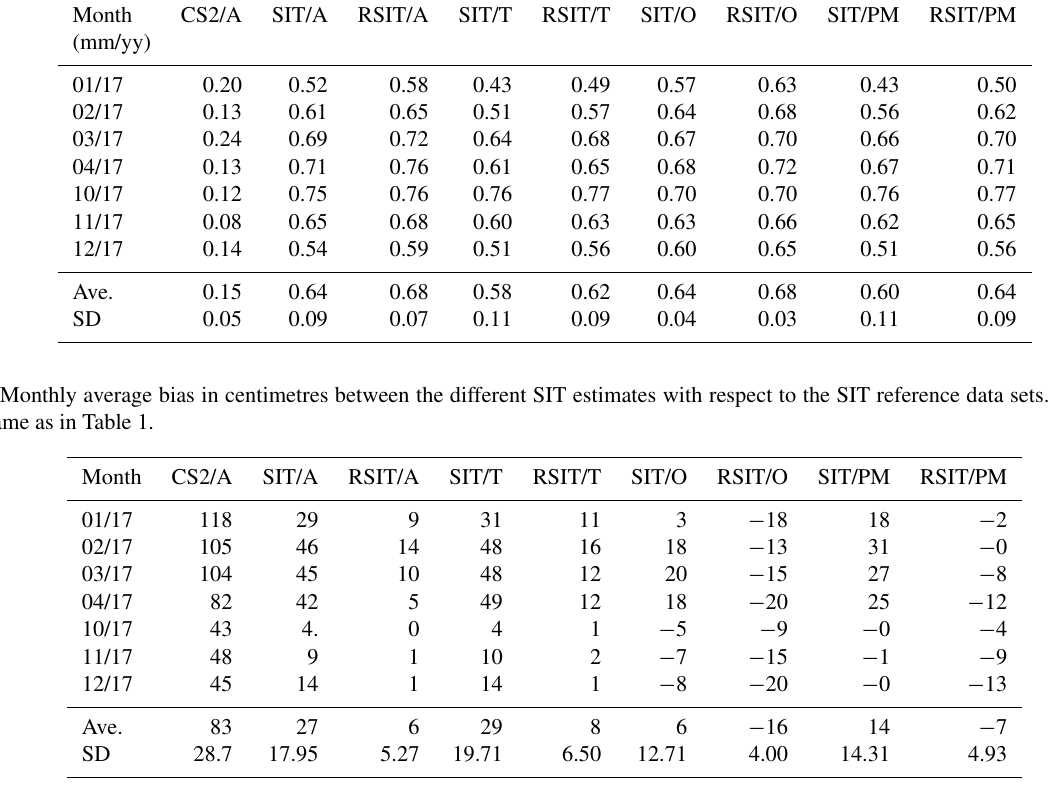
Table 3. Monthly average L1 difference in centimetres between the different SIT estimates with respect to the reference SIT data sets. The symbols are the same as in Table